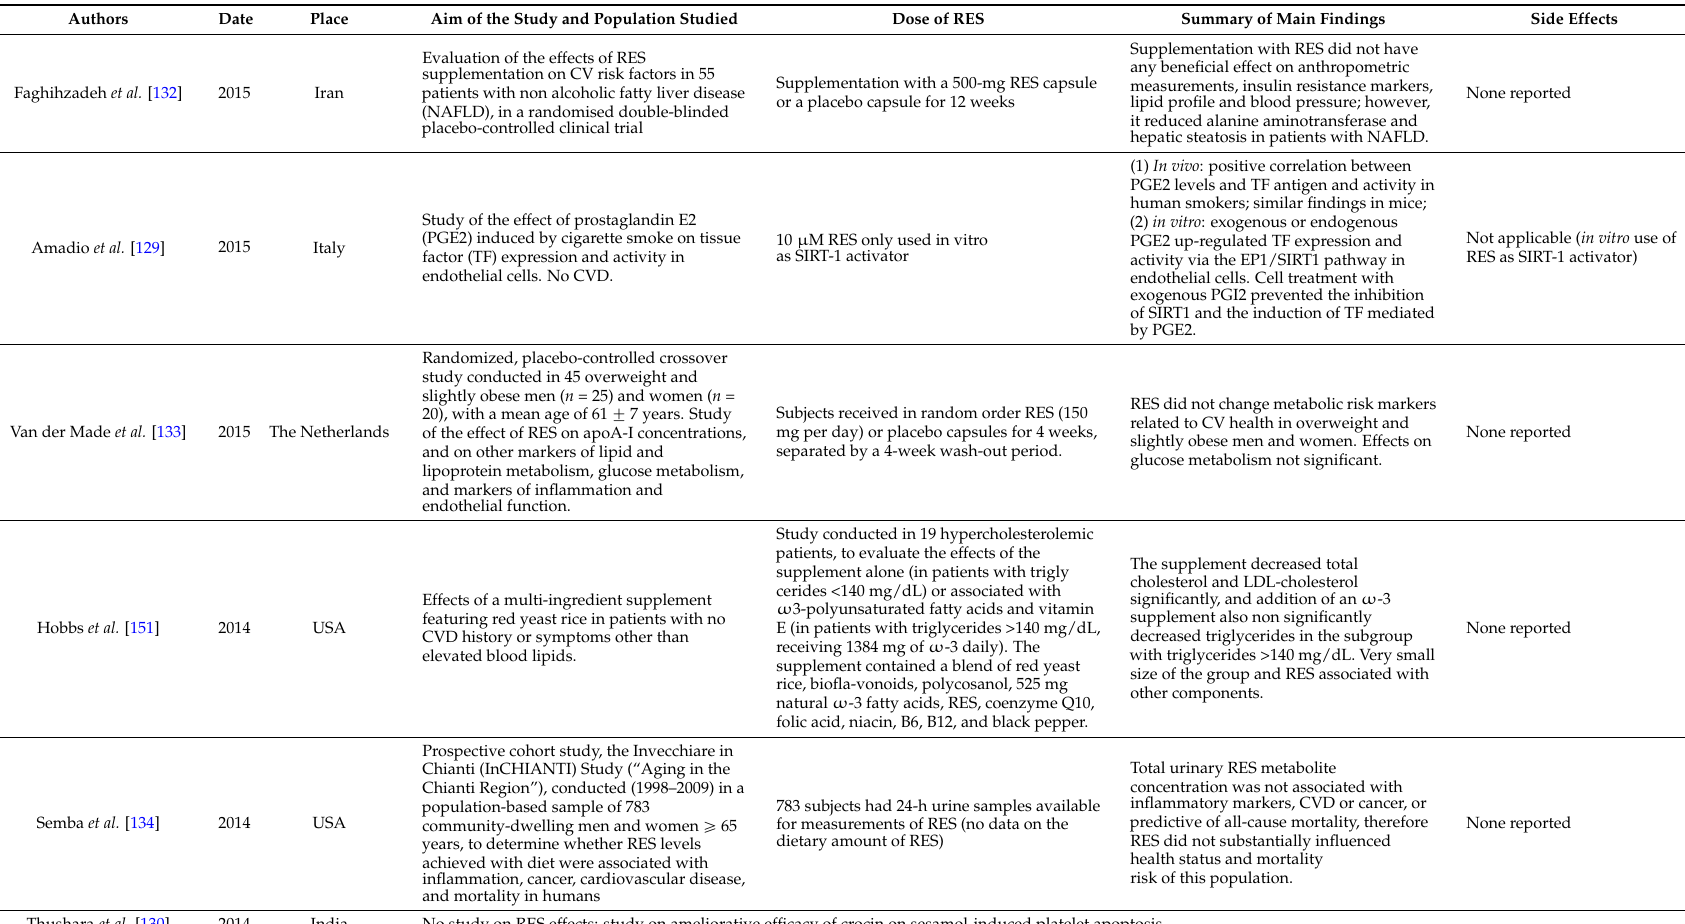
Table 1. Publications referred to as clinical trials using RES in CVDs. (1 mg/L RES = 4.38 µ mol/L